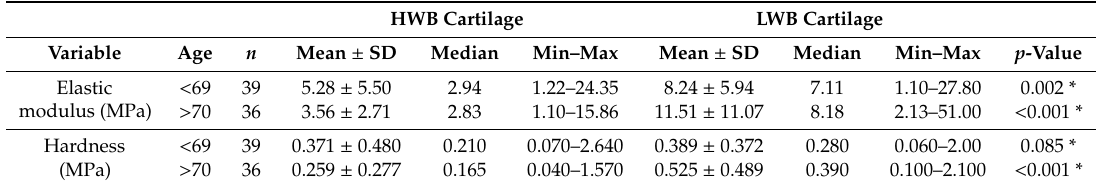
Figure 2. Scatter plot of the mean elastic modulus against age: ( a ) low weight bearing (LWB) sample and ( b ) high weight bearing (HWB) sample.